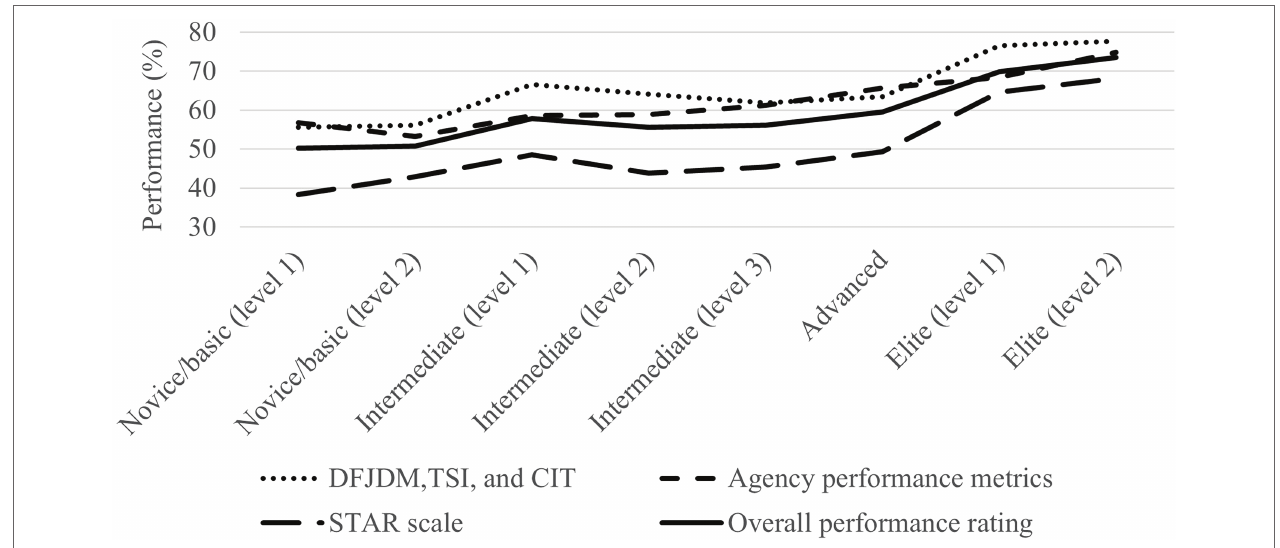
FIGURE 4 | Performance metrics (%) as a function of level of